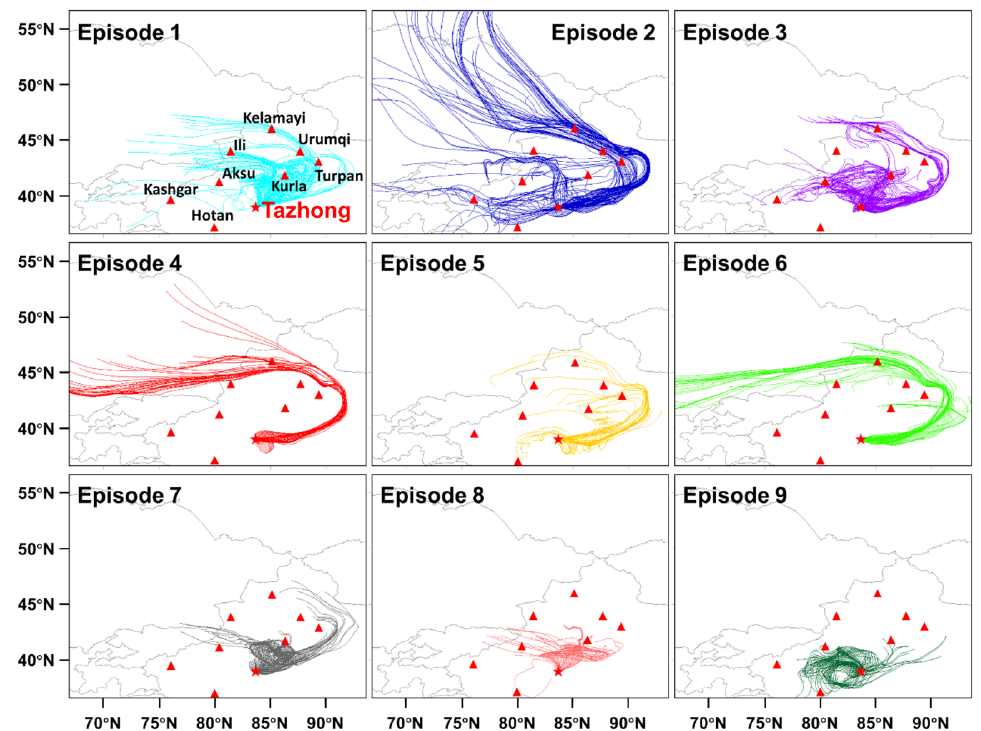
Figure 3. Back trajectories of air masses arriving in Tazhong at an elevation of 200 m during the nine episodic events. The 72 h of back trajectories were calculated, with a new trajectory starting every 1 h. See Table S2 for the start and end times of each episode. Red triangles = cities; red star = Tazhong, with city names shown in the Episode 1